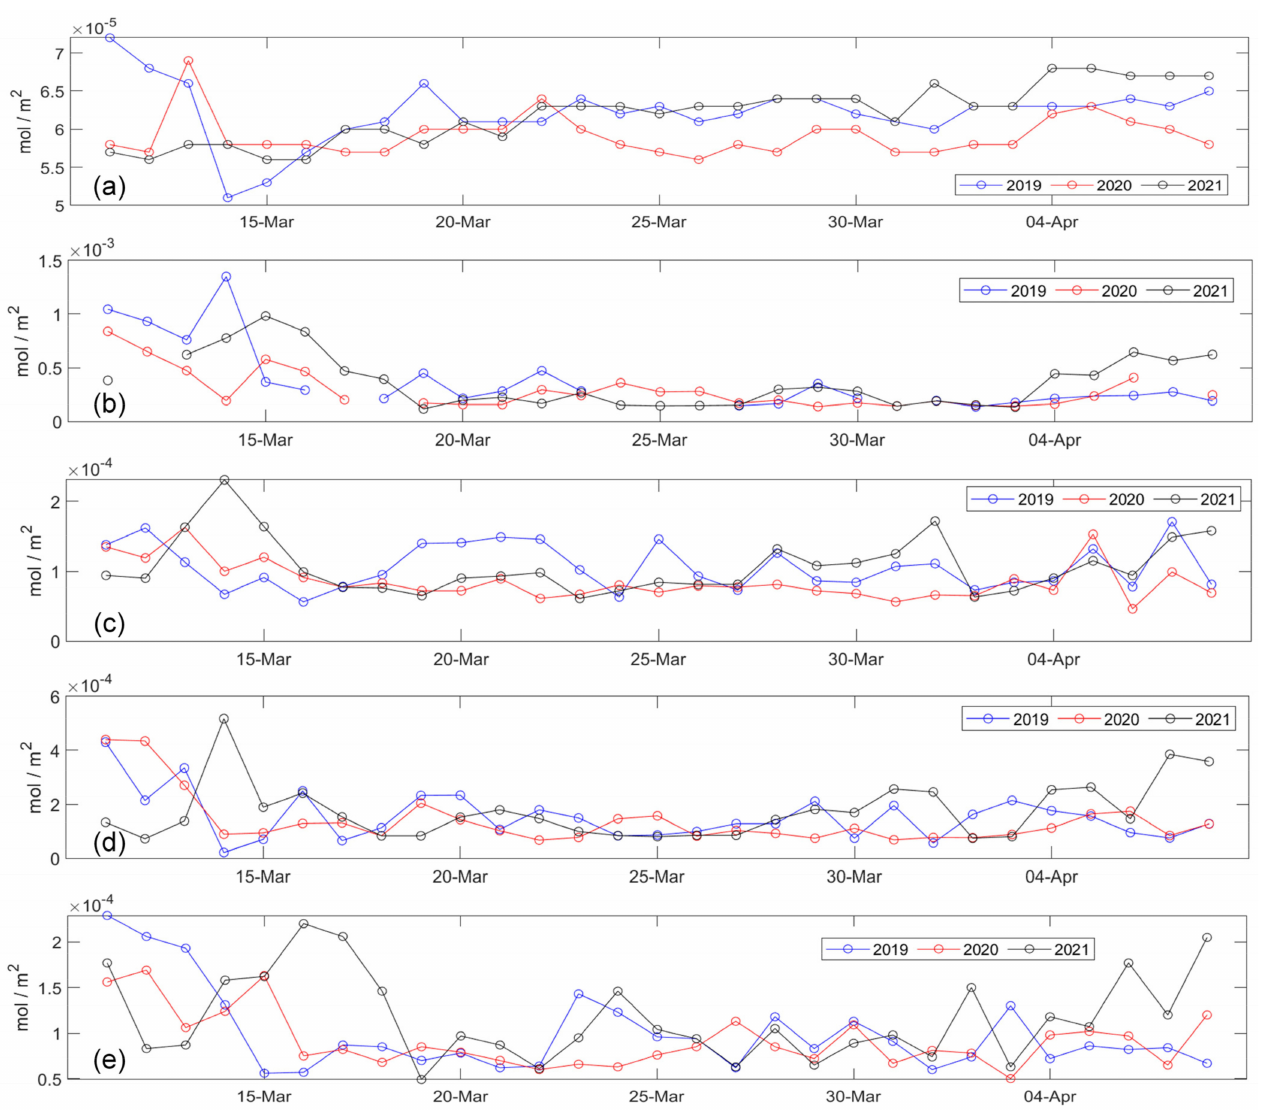
Figure 4. The trend of NO 2 over ( a ) Iran, ( b ) Tehran, ( c ) Tabriz, ( d ) Isfahan, and ( e ) Mashhad for the 30 day period (11 March–8